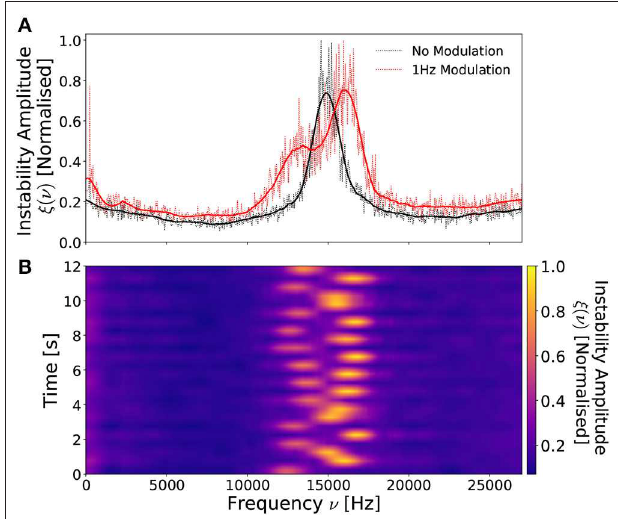
FIGURE 6 | Normalized (A) time-integrated instability amplitude profiles with (red curve) and without (black curve) a ν mod = 1 Hz, φ mod = 0.5 φ rf voltage amplitude modulation and (B) time-resolved instability profiles employing the same voltage amplitude modulation. Instability measured at the beam-conic interface ( R = –6 cm) downstream of the DL ( Z = 2 cm). Solid lines in (A) were smoothed employing a SavitzkyGolay filter. Operating conditions: helicon antenna supplied P rf = 300 W at ν rf = 13.56 MHz employing 0.25 mTorr argon with I 1,2 = 6 A solenoid